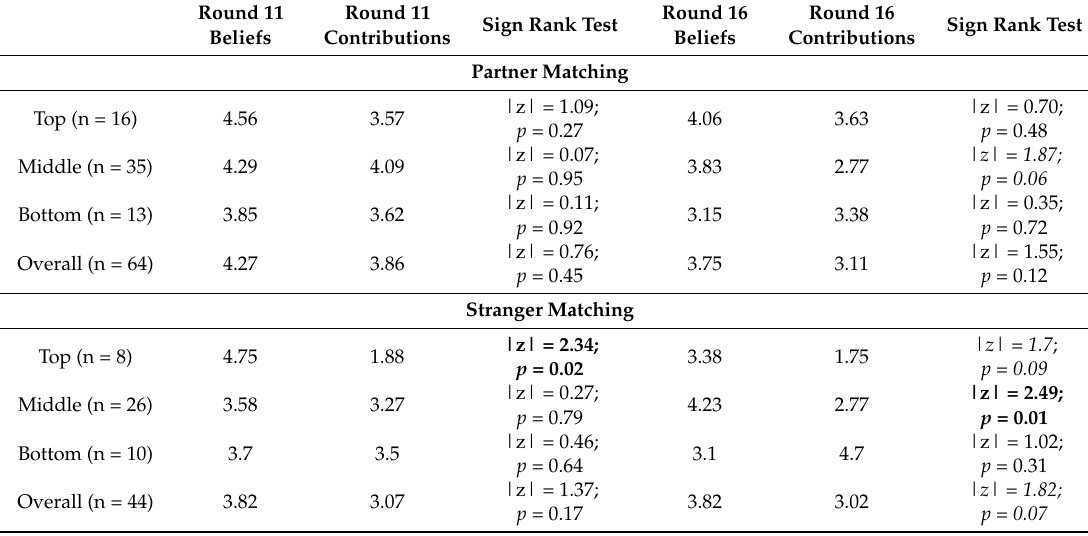
Table 8. Correlation of belief and contributions, by